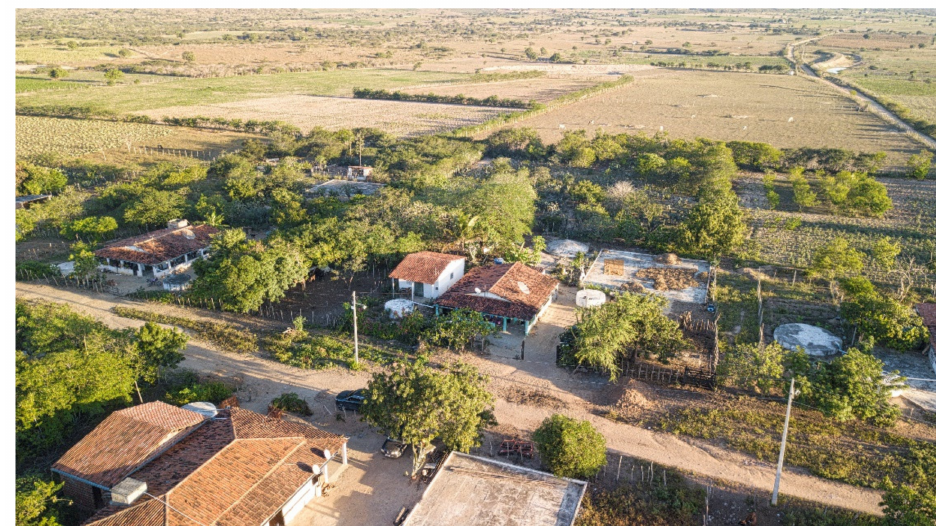
Figure 9. Aerial view of family farmers’ properties in the SAB, showing the great diversity of crops close to each other in small areas. Photo credit: Flavio Costa. Rem í gio, Para í ba, Brazil, May 2021. At the time of the collection, sample seeds were properly identified with data regarding their origin. At least 10,000 grains were collected from each sample for detection by immunochromatographic test at 0.1% sensitivity (1/1000 seeds). The sample was manually homogenized in clean, disposable plastic bags. After homogenization, 250 g of sample grains were crushed. The remaining volume was stored for counterproof tests as needed (Figure 10).